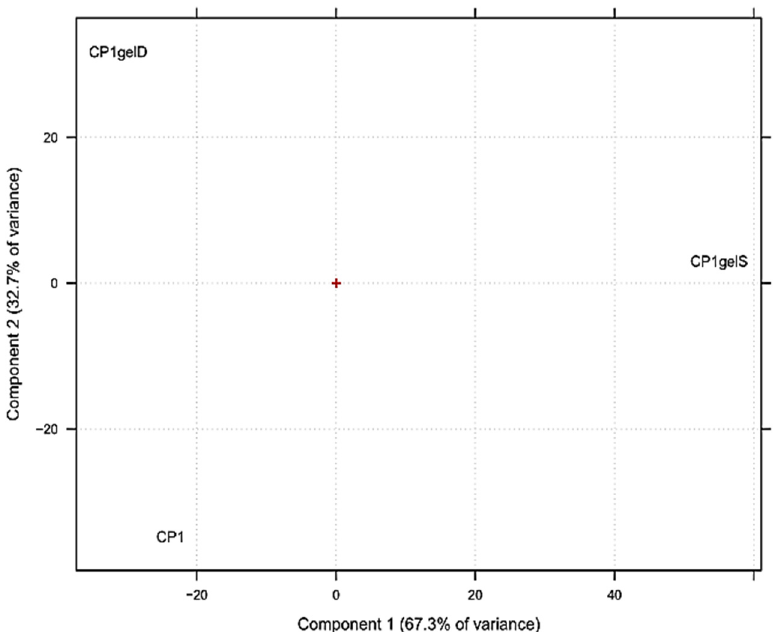
Figure 4. Results by PCAs performed on the matrix collecting spectral data of CP1, and of swollen and dried CP1-based gel, represented as a scores plot of PC1 vs. PC2. Red plus sign indicates score zero both on PC1 and on PC2.